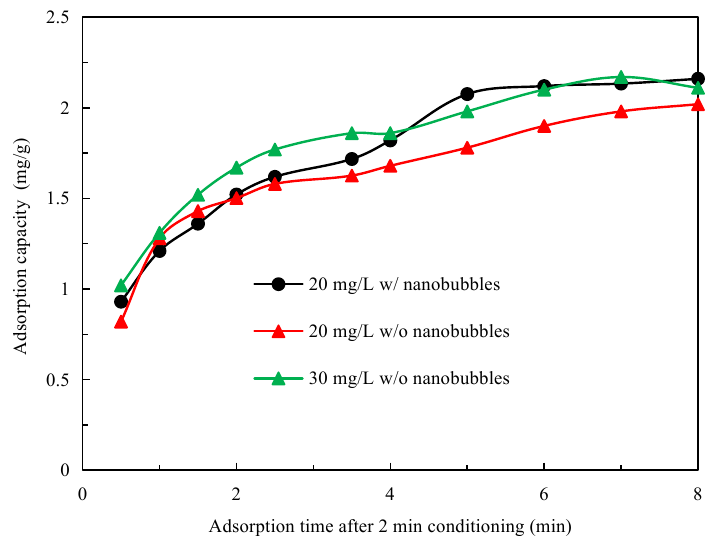
Figure 5. Adsorption capacity of diesel on graphite surface as a function of time after conditioning.